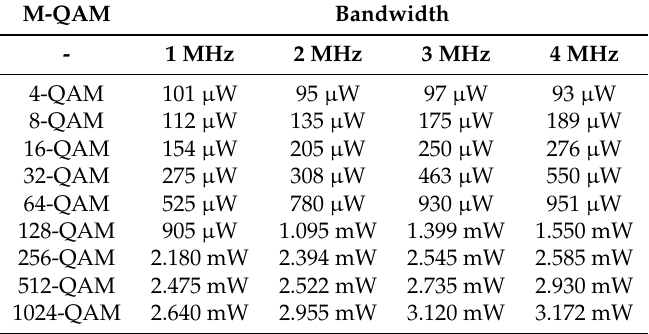
Table 4. Minimal optical power levels of laser for multiple bandwidth and modulations measured after passing through